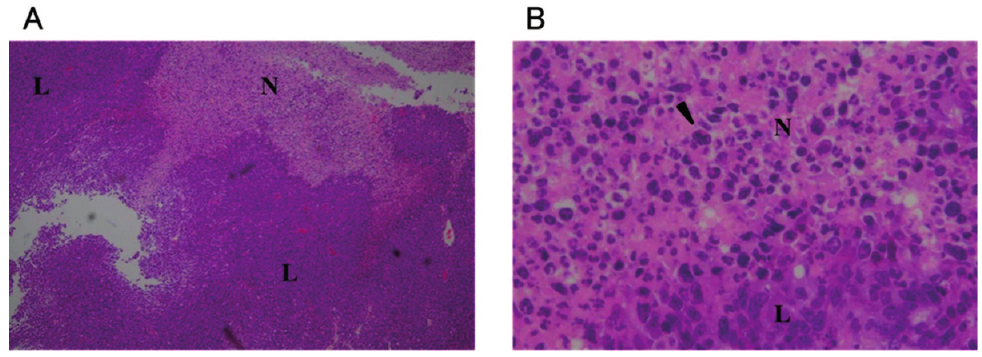
Figure 4. Histological images of tumors after administration of 208 mM ozonated water. the O 3 -4/1 day group is ( A , B ); O 3 -4/3 day group is ( C , D ); O 3 -4/7 day group is ( E , F ). Low magnification (40×): ( A , C , E ); High magnification (400×): ( B , D , F ). All sections were stained with hematoxylin and eosin. N: necrotic area; L: viable tumor area; arrow: site of injection; arrowhead: pyknotic